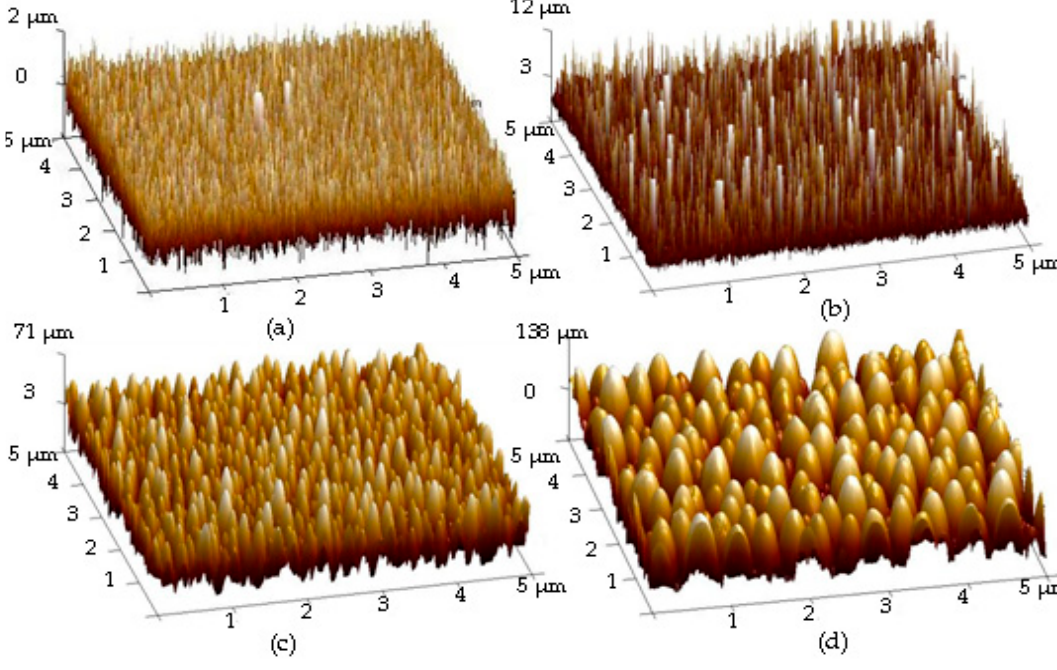
Figure 4. Surface Roughness of: ( a ) the organosilicon film directly deposited onto the silicon substrate; and ( b ) the film deposited onto the as-deposited Ag seed layer; as well as the films deposited onto the annealed Ag seed layers deposited at for: ( c ) 150 s; and ( d ) 480 s.